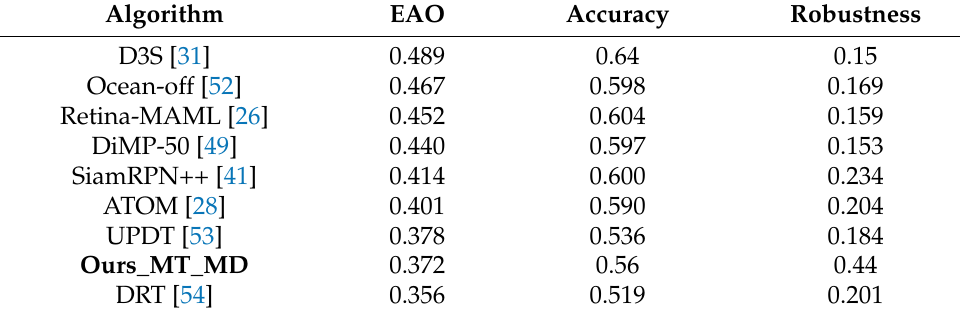
Table 3. Comparison on VOT-2018.